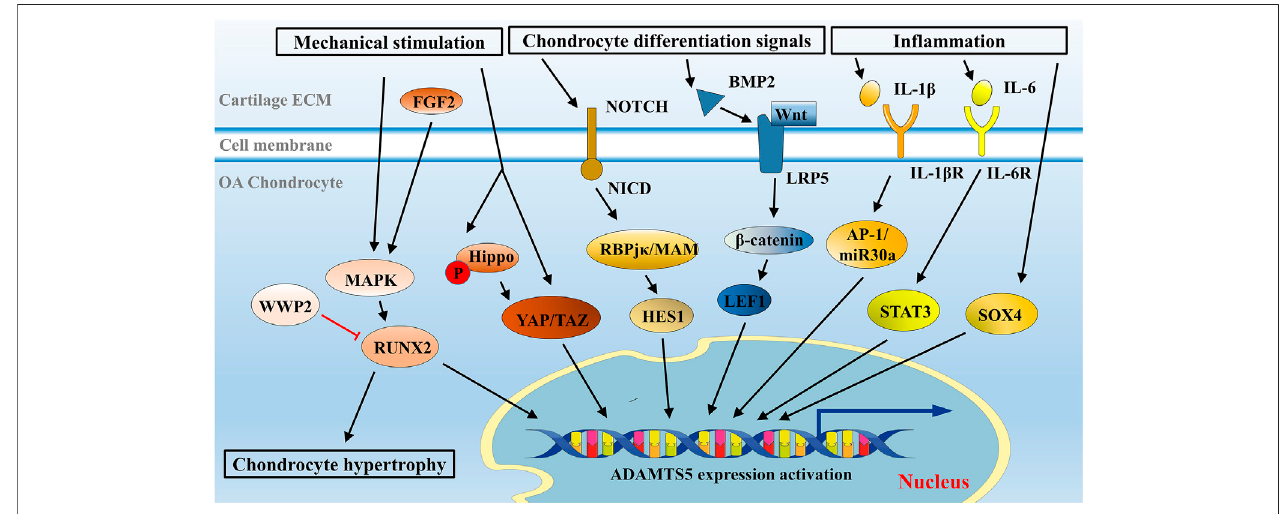
FIGURE 3 | Overview of signaling network in ADAMTS5 regulation in chondrocytes. Mechanical stimulation, cell differentiation signals, and in fl ammatory environmentareprimaryinitiatorstoADAMTS5overexpressioninOA.Signalingpathwayswereillustratedwithrecentinsights,suchasRunx2signaling,Notchsignaling, Wnt/ β -catenin signaling,andcytokine-mediatedsignaling pathways, and somenewlydiscussed signalingpathways,suchasYAP/TAZsignaling andSox4signaling are presented in this schematic presentation.